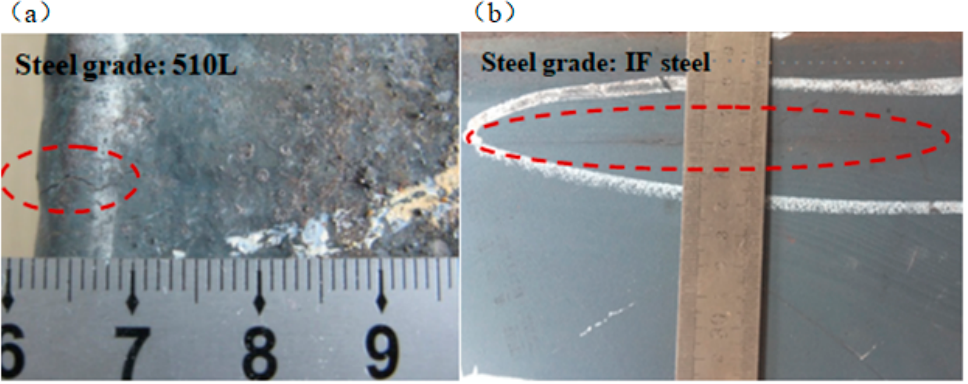
Figure 17. Production defects using the common mold. ( a ) Corner transverse cracks; ( b ) Edge defects of the hot rolled sheet.